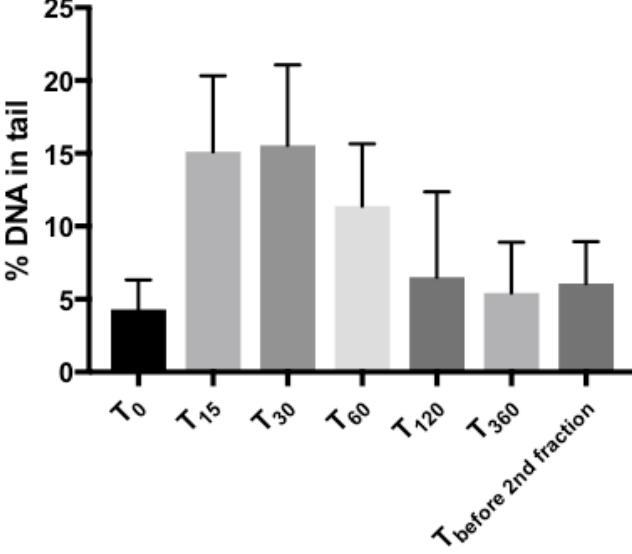
Figure 1. Time-course of DNA damage measured by comet assay. Tail intensity (%DNA in tail) measured at indicated time-points after completion of radiation treatment (T 0 –before treatment, T 15 , T 30 , T 60 , T 120 , T 360 , minutes after treatment, respectively). Mean values ± SD are shown. Significances in differences are displayed in Table 1. Table 1. Differences of median tail intensity (%DNA in tail), comet assay (%; 95% CI). T 0 , T 15 , T 30 , etc. indicate the time-points in minutes after completion of radiation treatment.